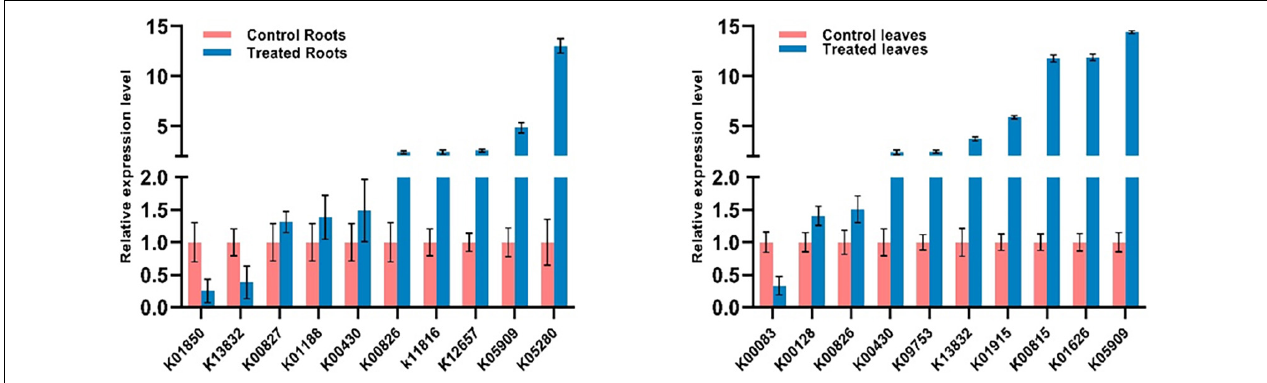
FIGURE 9 | Changes in the expression of 10 selected DEGs in the roots (left) and 10 selected DEGs in the leaves (right) of S. argel plants in response to salt stress based on qRT-PCR